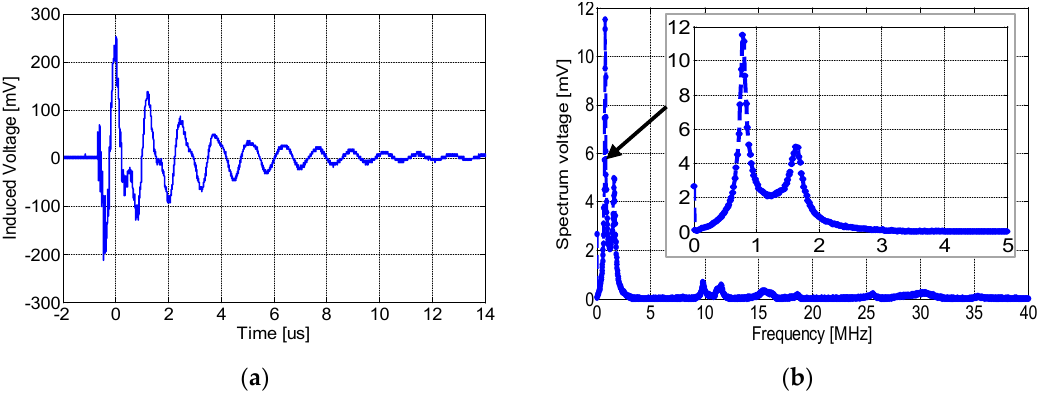
Figure 16. ( a ) The time-domain wave of the output voltage at 8.2 kV and ( b ) frequency spectrum of the HFCT sensor.